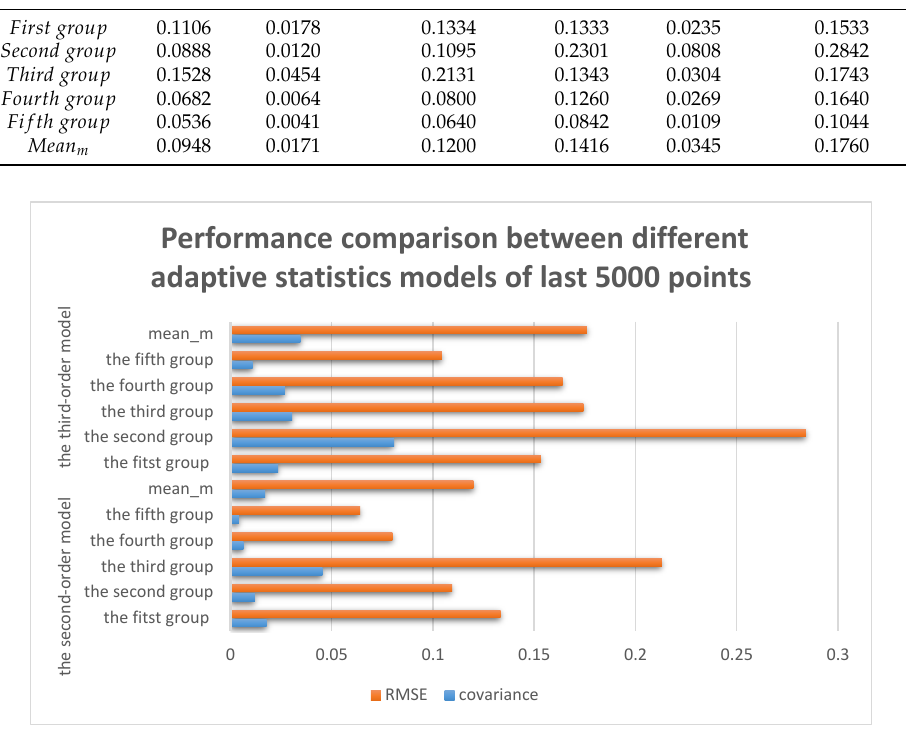
Figure 8. Covariance and RMSE of the adaptive statistics models of the last 5000